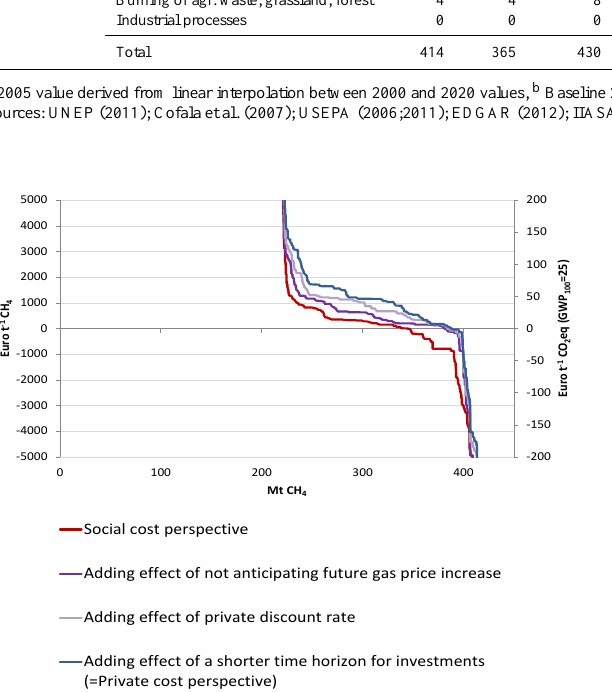
Fig. 7. Global CH 4 mitigation cost curve 2030 with private and so- cial cost perspectives including a separation of the effects of the differences in assumptions between the social and private cost per-